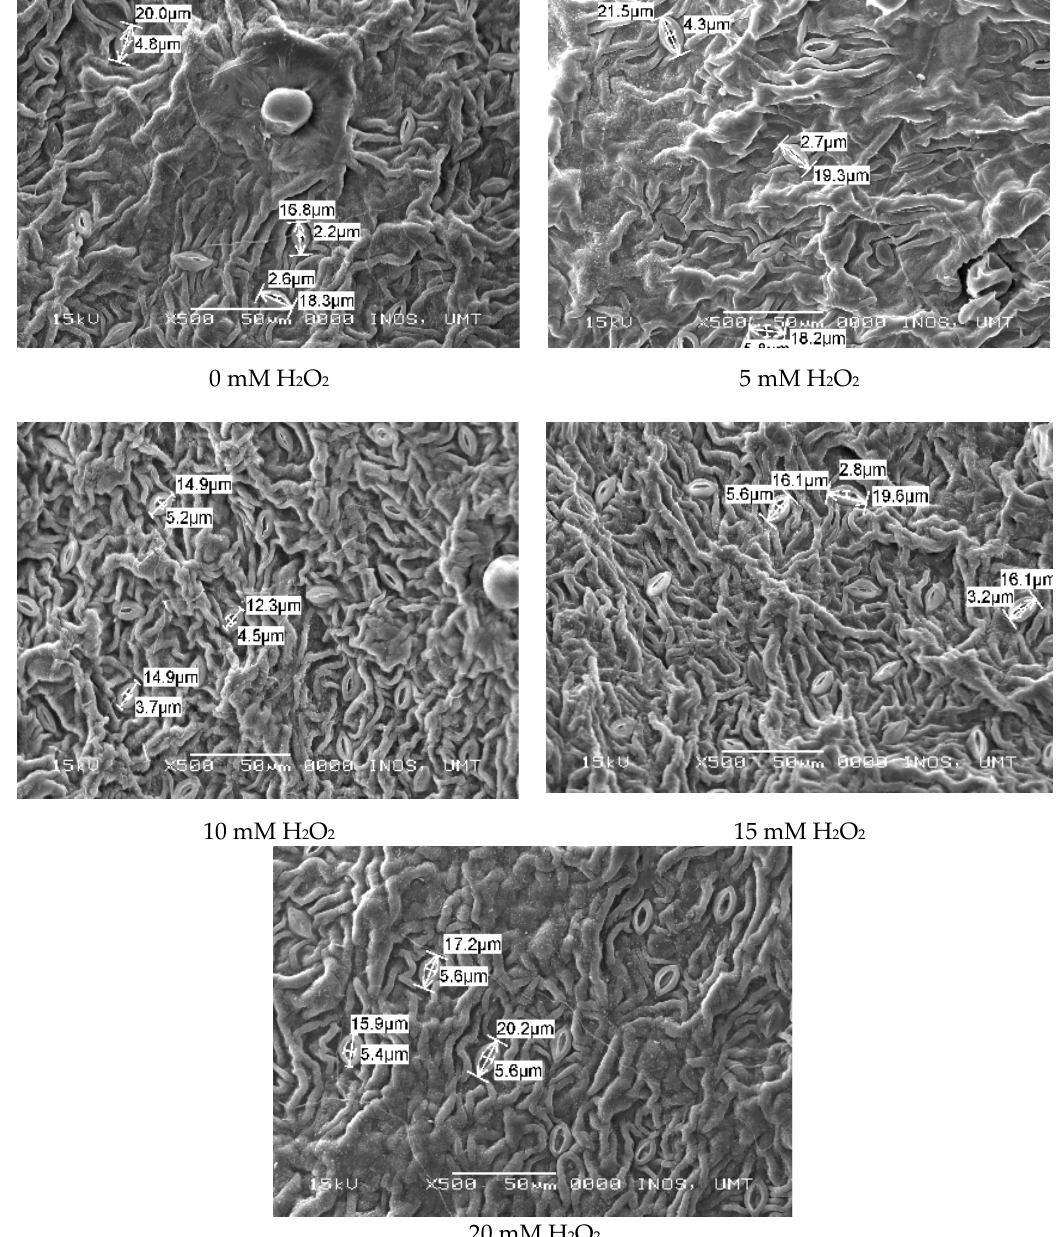
Figure 3. SEM photographs showing the stomatal closure at lower surface of the treated and untreated leaves Ficus deltoidea var. deltoidea plant .